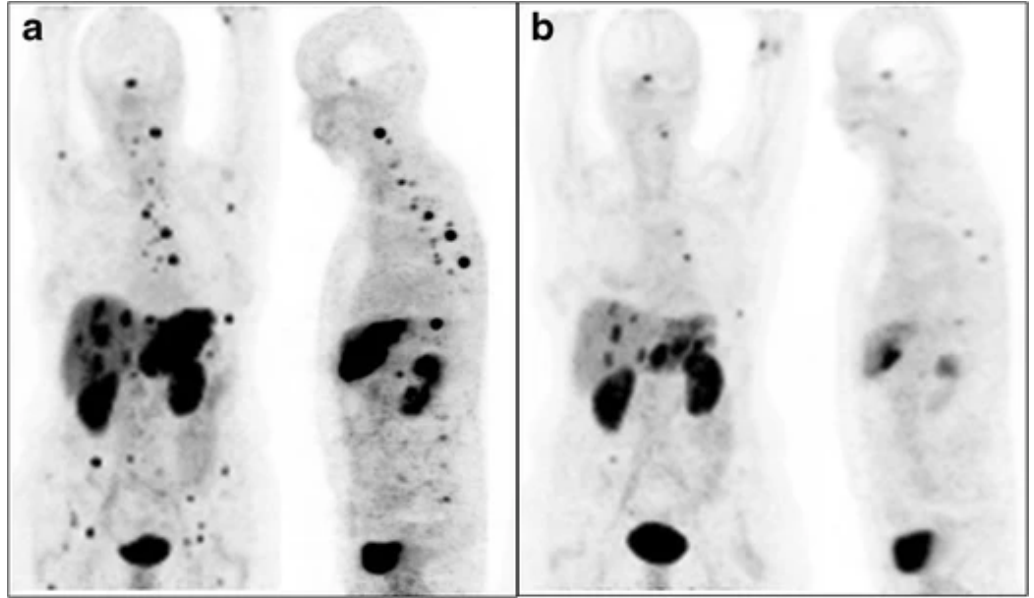
Figure 4. A patient with an extensive tumor burden in the left liver lobe and multiple lesions in the right lobe and disseminated bone marrow metastases predominantly in the spine and pelvis (( a ) coronal and sagittal maximum-intensity projections 68 Ga-DOTATOC PET). Liver metastases showed significant shrinkage after administration of 10.5 GBq of 213 Bi-DOTATOC into the common hepatic artery ( b ). Additional systemic efficiency resulting from the 213 Bi-DOTATOC reaching the systemic circulation after the first pass of the liver was noted after 6 months in that most of the bone marrow metastases had also diminished ( b ). This image nicely demonstrates the potential of alpha- emitters and the feasibility of intra-arterial administration of peptide receptor radionuclide